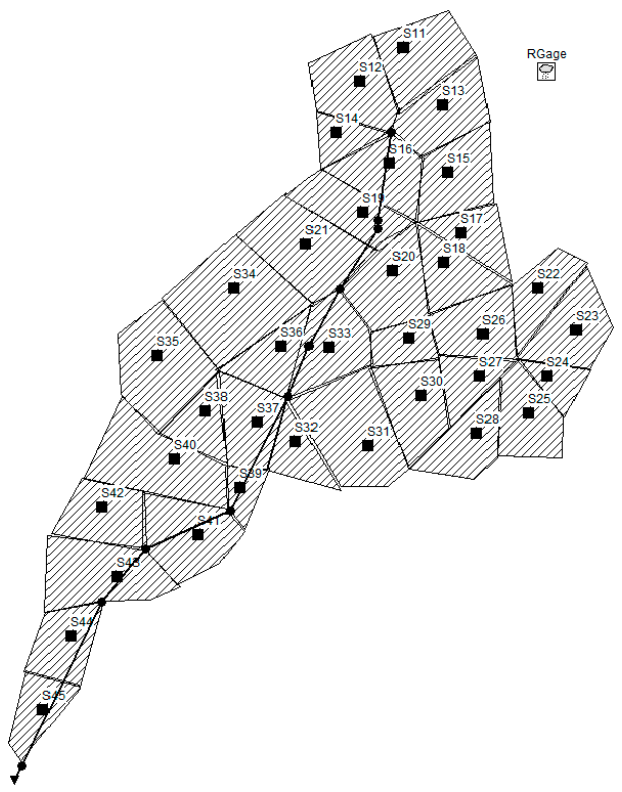
Figure 2. Drainage system in the base case in the Storm Water Management Model (SWMM) with